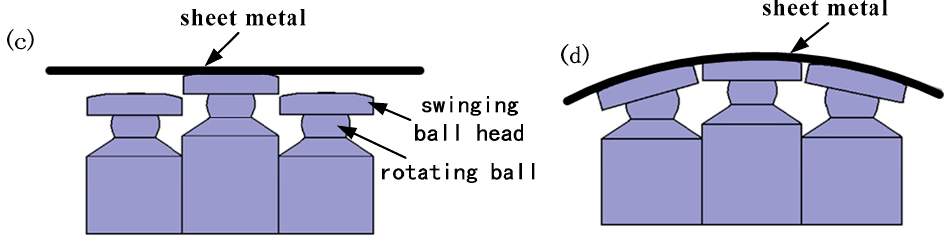
Figure 4. Forming process of fixed ball head and swinging ball head: ( a ) before forming by fixed ball head; ( b ) after forming by fixed ball head; ( c ) before forming by swinging ball head; ( d ) after forming by swinging ball head.